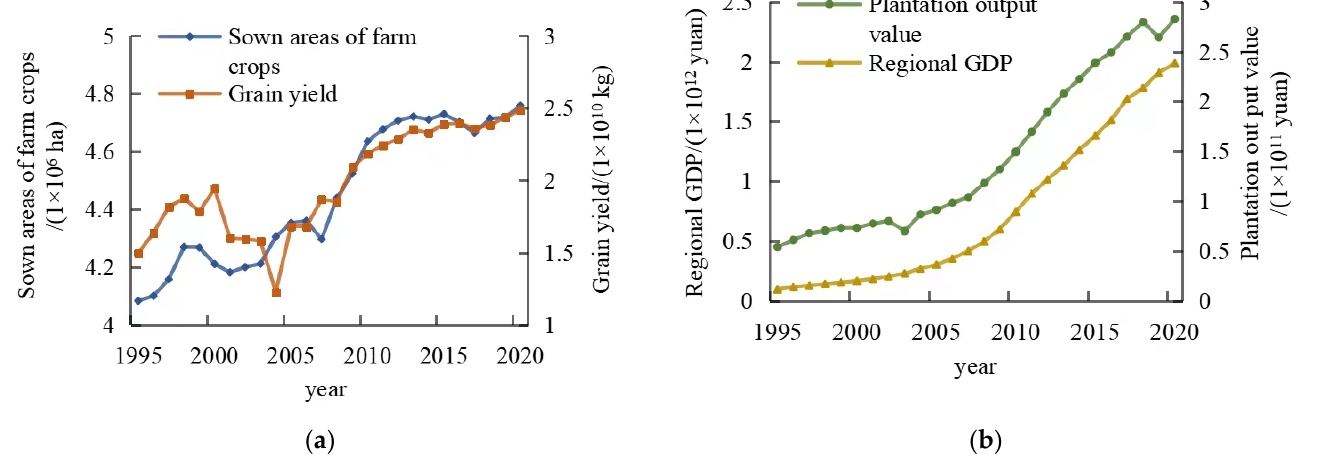
Figure 5. ( a ) Changes in agriculture development data in the Huaibei region of the Jiangsu province between 1995 and 2020, and ( b ) changes in economic data in the Huaibei region of the Jiangsu province between 1995 and 2020.